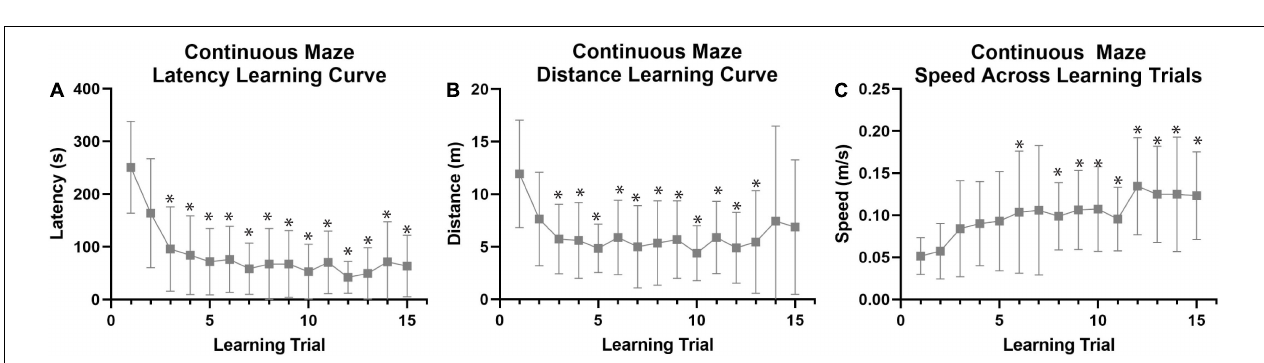
FIGURE 5 | Continuous spatial maze learning performance in naked mole-rats. Data were collected ( n = 27) using a continuous maze design (see Figure 1B ) to investigate spatial learning and memory capabilities in naked mole-rats across 15 training trials (5 trials per day for 3 days). (A) Average latency to the reward chamber revealed a distinct learning curve across training/learning trials. Comparison of trial 1 to trials 2–15 revealed a significant decrease in latency by trial 3. (B) Average total distance traveled also exhibited a learning curve across training/learning trials. Comparison of trial 1 to trials 2–15 revealed a significant decrease in distance by trial 3. (C) Average speed traveled significantly increased across training trials by Trial 6. ∗ p < 0.05 when compared to Trial 1. m, meters; s,